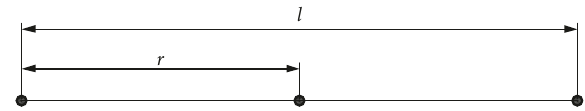
Figure 7: Fractal graphics of “straight-line” blasting